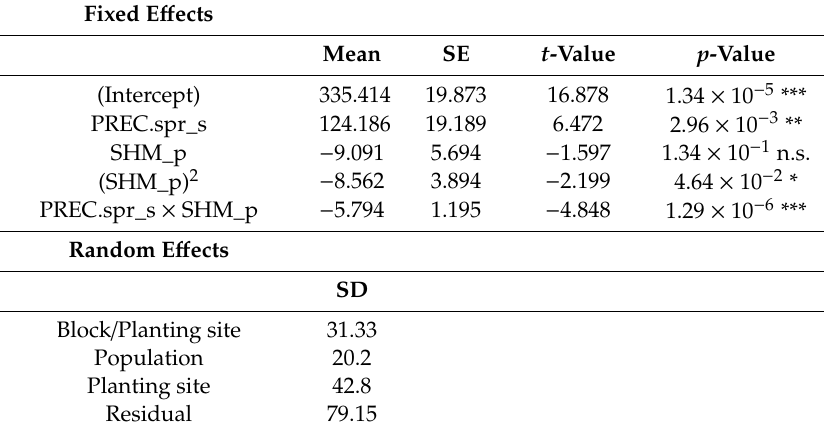
Table 3. Mean, standard error (SE), t -values and p -values are given for the fixed e ff ects of the tree height growth model in the first panel; and standard deviation (SD) for the random e ff ects are given in the second panel.